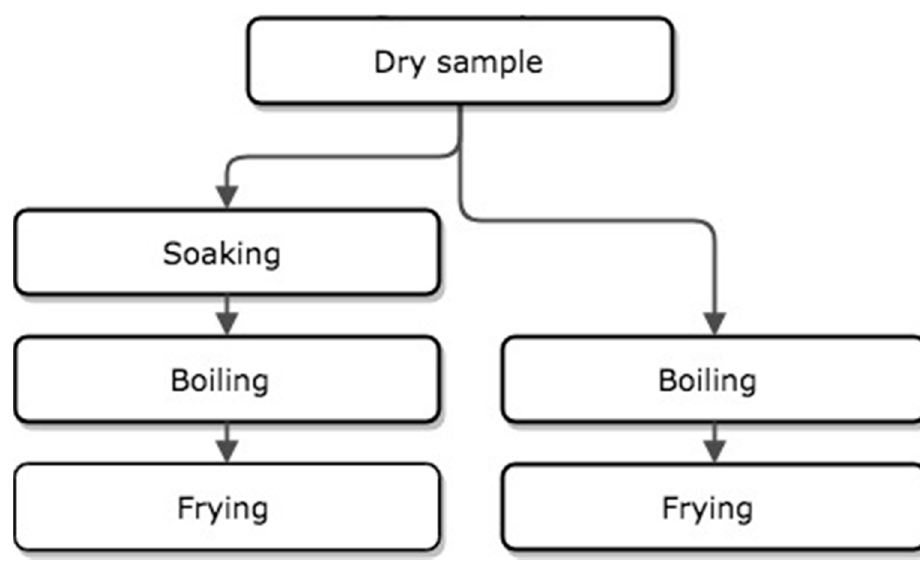
Figure 1. Overview of the study design with the different bean preparation methods.